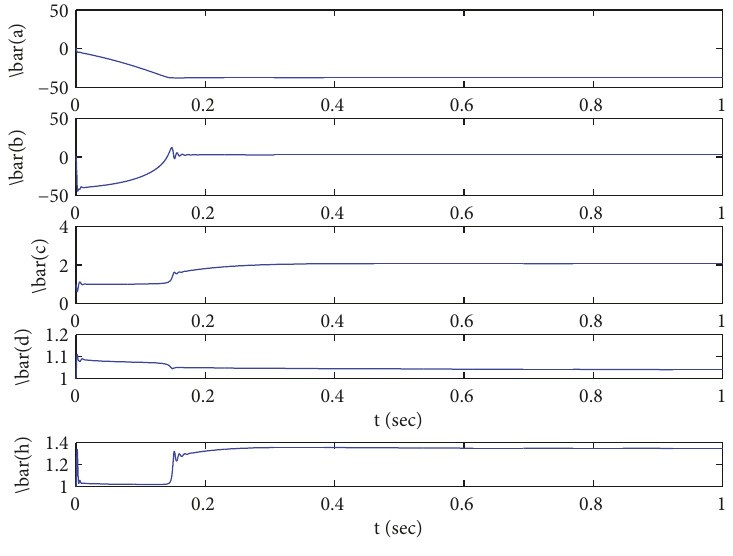
Figure 5: The time response of states 𝑎, 𝑏,𝑐,𝑑,ℎ of system (36) with controller